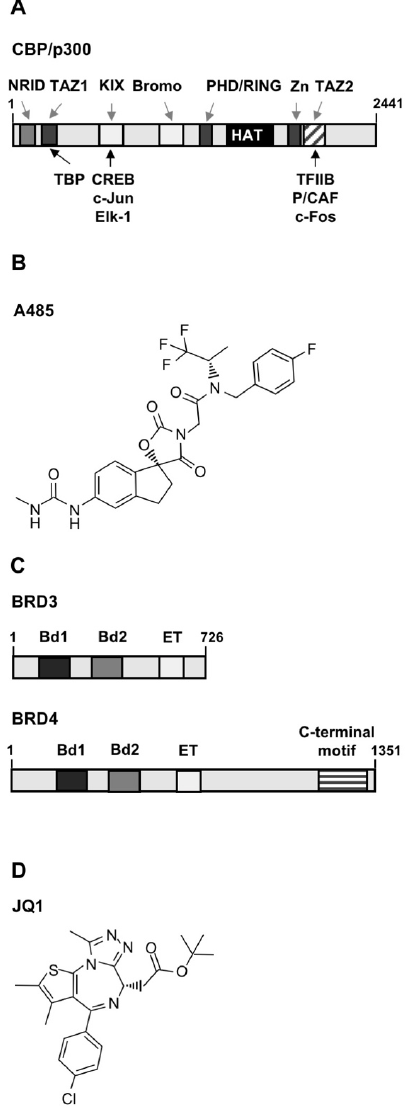
Figure 1. Pharmacological inhibitors of epigenetic gene regulation. ( A ) Modular structure of the transcriptional coactivator and acetyltransferase CBP. The paralog p300 has a similar modular structure. Both proteins have a nuclear receptor interaction domain (NRID), two transcriptional adapter zinc finger domains (TAZ), a kinase inducible domain interacting domain (KIX) that binds CREB, the CREB-related protein ATF-1, c-Jun and other transcription factors, a bromodomain, a PHD-RING module, and a histone acetyltransferase (HAT) domain. The C-terminal TAZ domain binds c-Fos. ( B ) Chemical structure of the CBP/p300 catalytic inhibitor A485. ( C ) Modular structure of the BET proteins BRD3 and BRD4. BET proteins have two bromodomains (BD) as well as an extra-terminal (ET) domain that functions as a protein binding module for other chromatin-modifying proteins. BRD4 contains additionally a C-terminal domain (CTD) that functions as a binding site for P-TEFb (positive transcription elongation factor b). ( D ) Chemical structure of the pan-BET-inhibitor